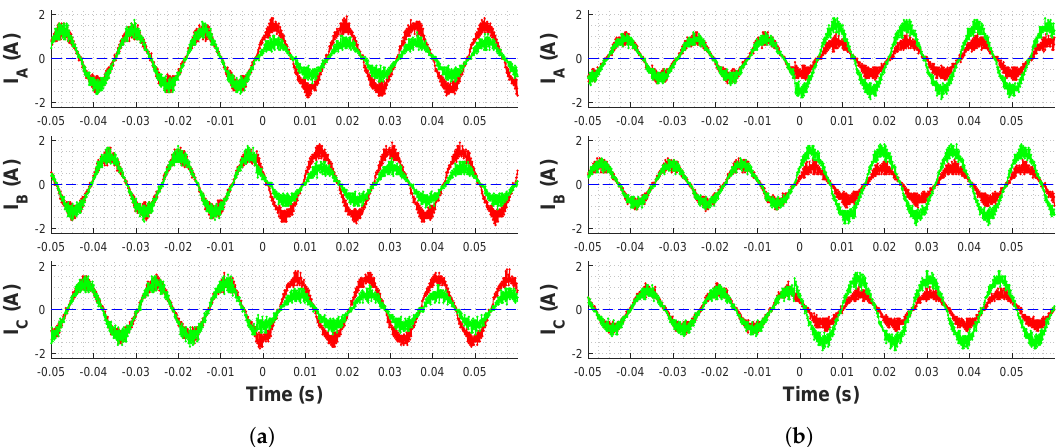
Figure 15. Experimental three phase test cases demonstrate the ability to control load sharing between two different current-controlled inverters by changing the virtual output impedance of one of them [20]. ( a ) The load carried by one inverter is decreased by increasing virtual output impedance. ( b ) The load carried by one inverter is increased by decreasing virtual output